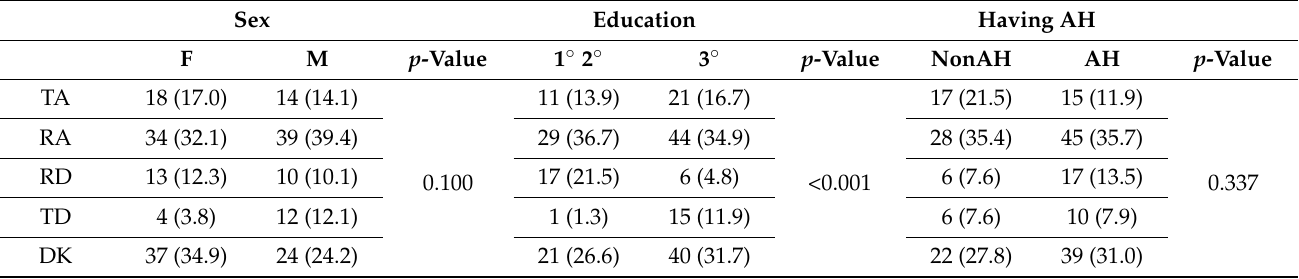
Table 13. Air pollution (smog) as a factor that increases the incidence of hypertension by gender, education, and having hypertension (N =